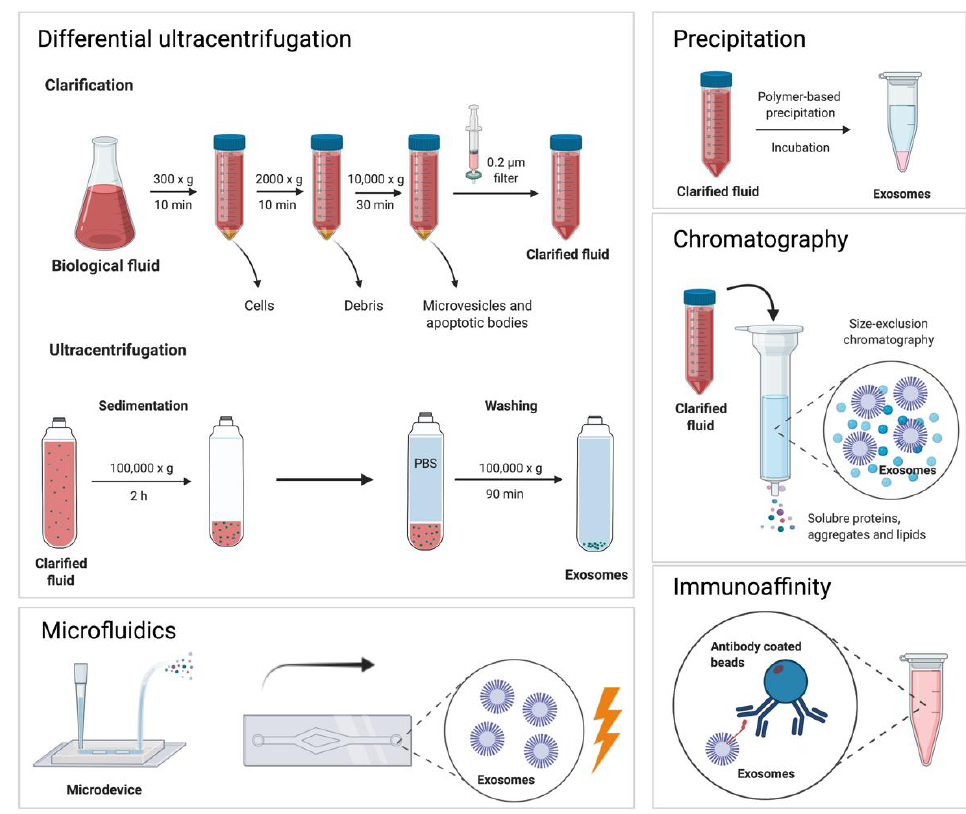
Figure 2. The most commonly used exosome isolation methods: Differential ultracentrifugation involves a series of centrifugation steps at low speed to remove larger particles. Afterwards, ultracentrifugation is used to pellet exosomes and to further purify the sample. Microfluidics, precipitation, chromatography and immunoaffinity approaches can provide a comparable yield and purity when compared to ultracentrifugation.